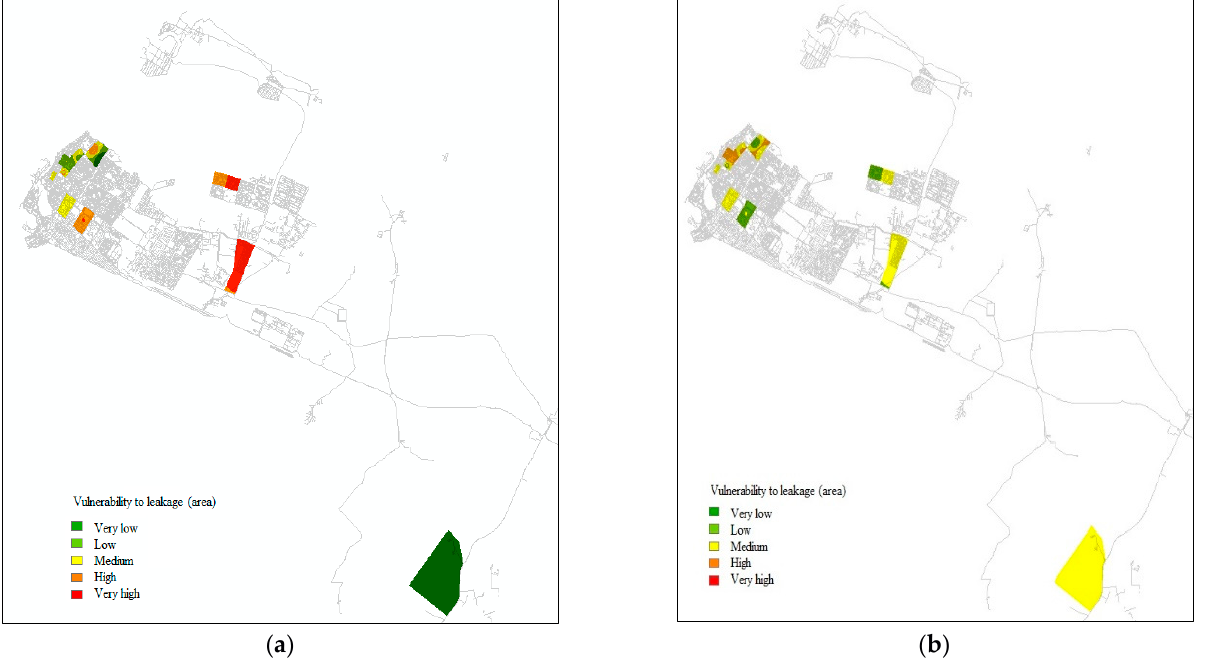
Figure 9. Vulnerability maps. ( a ) Highest drop values; ( b ) lowest drop values.